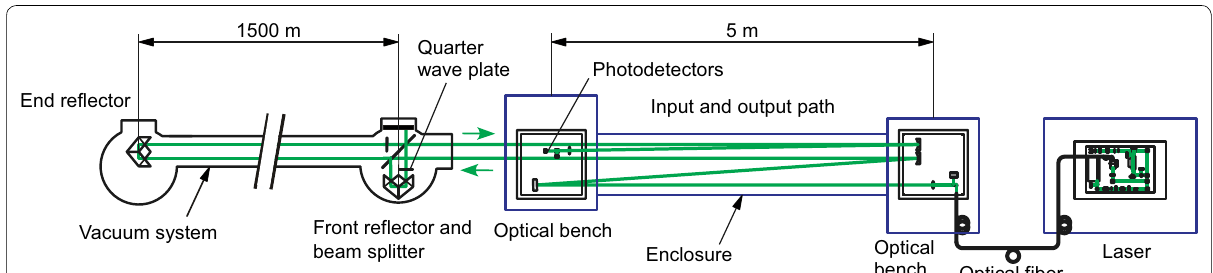
Fig. 2 Optical layout of the 1500-m laser strainmeter. Two retroreflectors, each housed in a chamber, and a beam splitter form a Michelson interfer- ometer with a high-frequency-stabilized